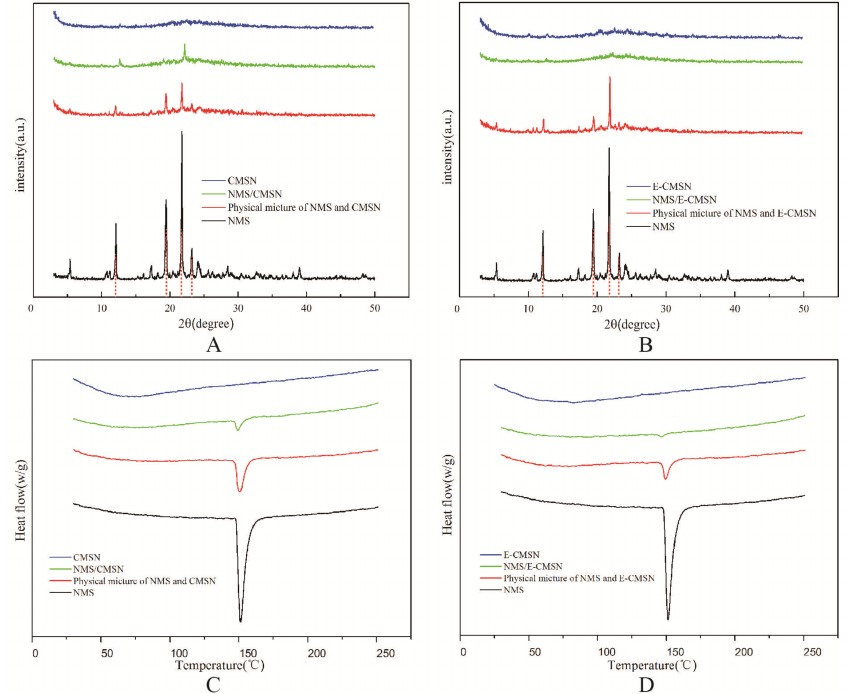
Figure 5. ( A ), XRD patterns of NMS, CMSN, NMS / CMSN, physical mixture of NMS and CMSN